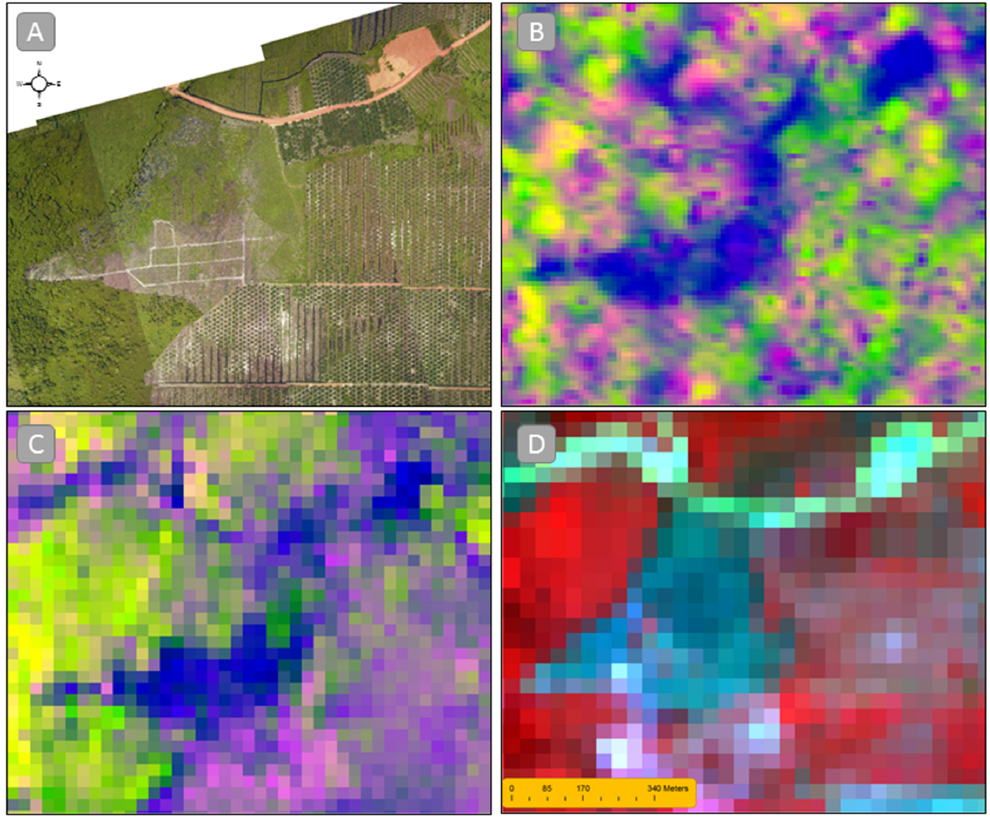
Figure 5. Co-located examples of ( A ) airborne imagery; ( B ) Sentinel-1 (R:VV,G:VH,B:VH 2 ); ( C ) PALSAR-2 (R:HH,G:HV,B:HV 2 ); and ( D ) Landsat-8 (R:5, G:4, B:3).